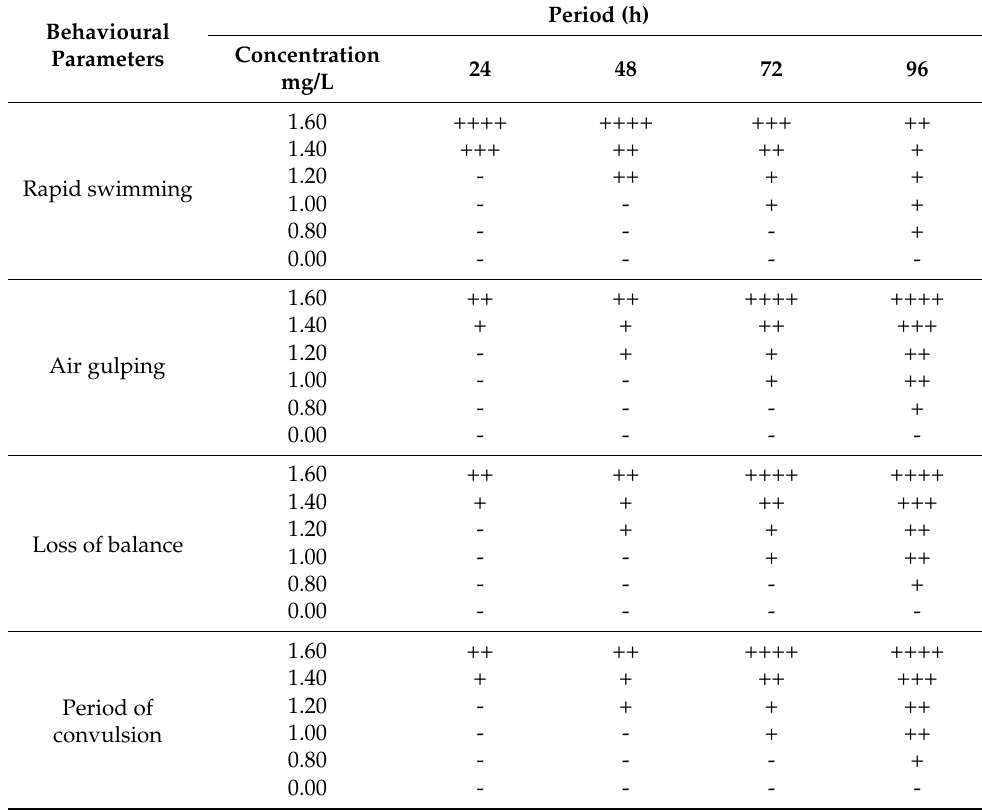
Table 1. The behaviour of Heterobranchus bidorsalis exposed to acute doses of NTL.